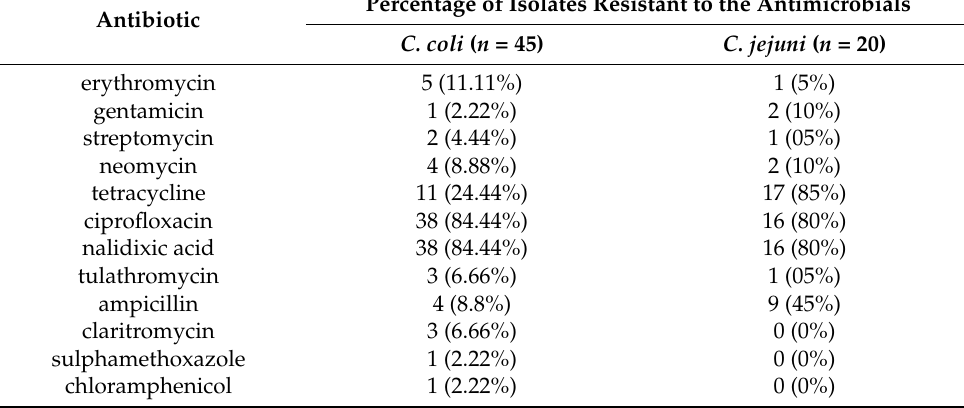
Table 3. Percentage of isolates resistant to tested